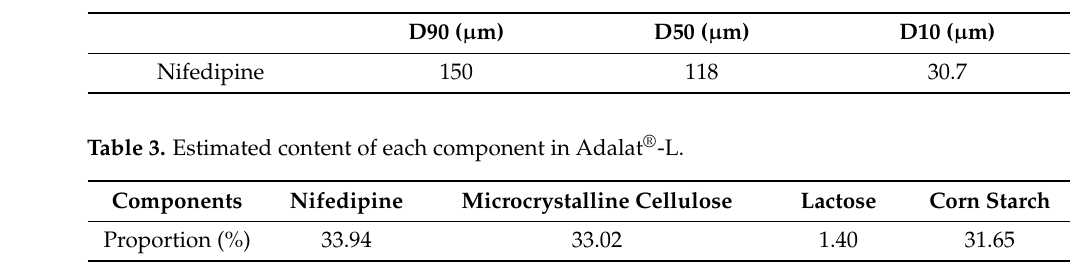
Figure 2. Raman mapping of Adalat ® -L, and distributions of nifedipine, microcrystalline cellulose, lactose, and corn starch. Scale bar is 200 µ m. Table 2. Particle size of nifedipine in Adalat ® -L.